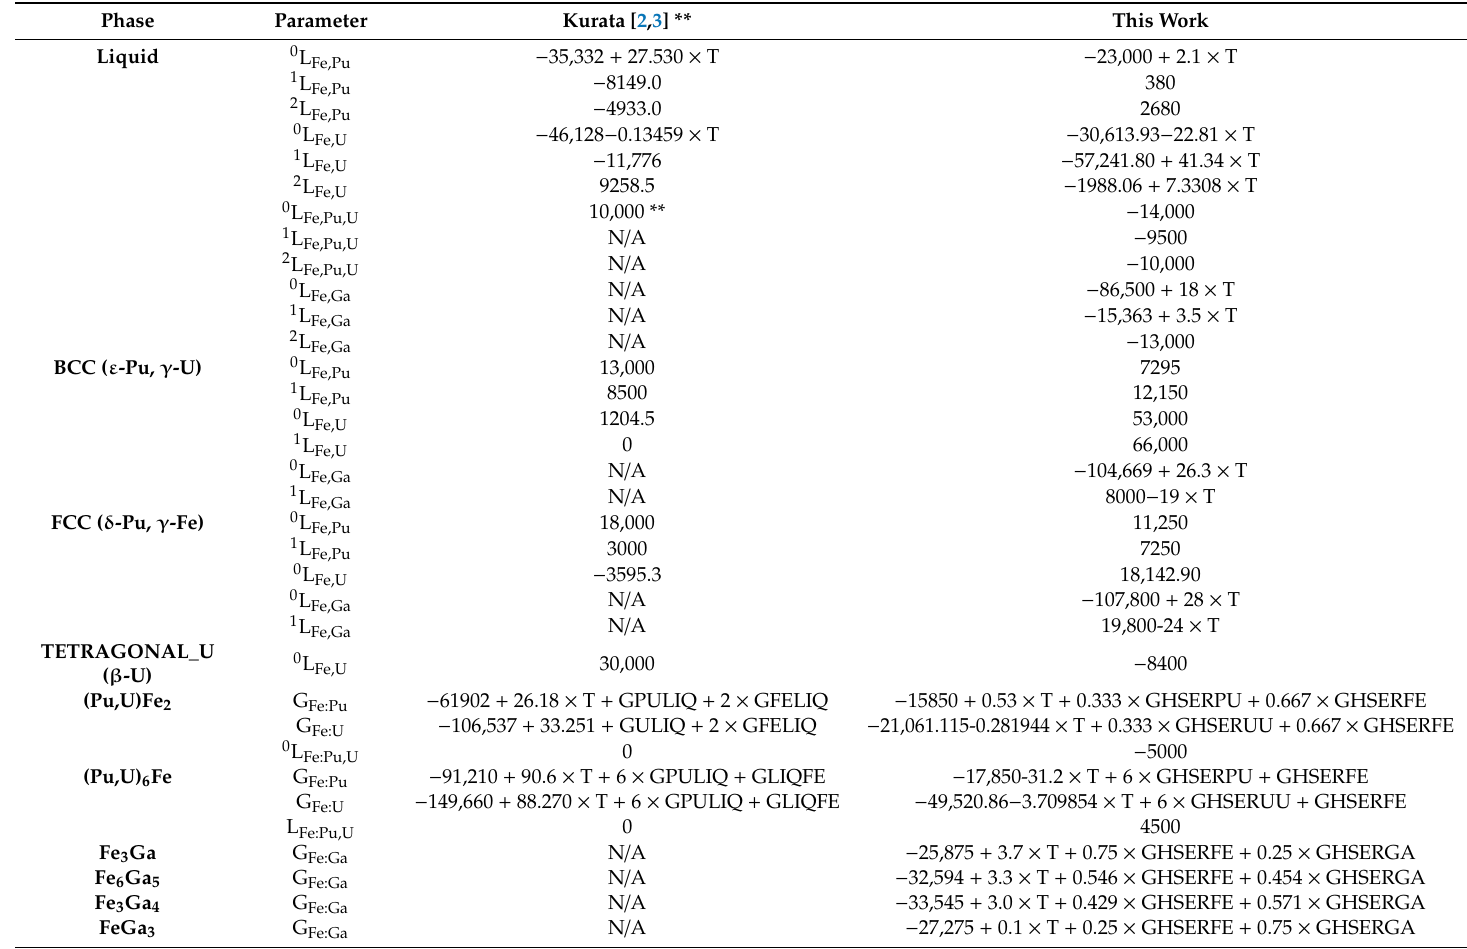
Table 4. Parameters for Pu-Fe, U-Fe, Pu-U-Fe and Fe-Ga